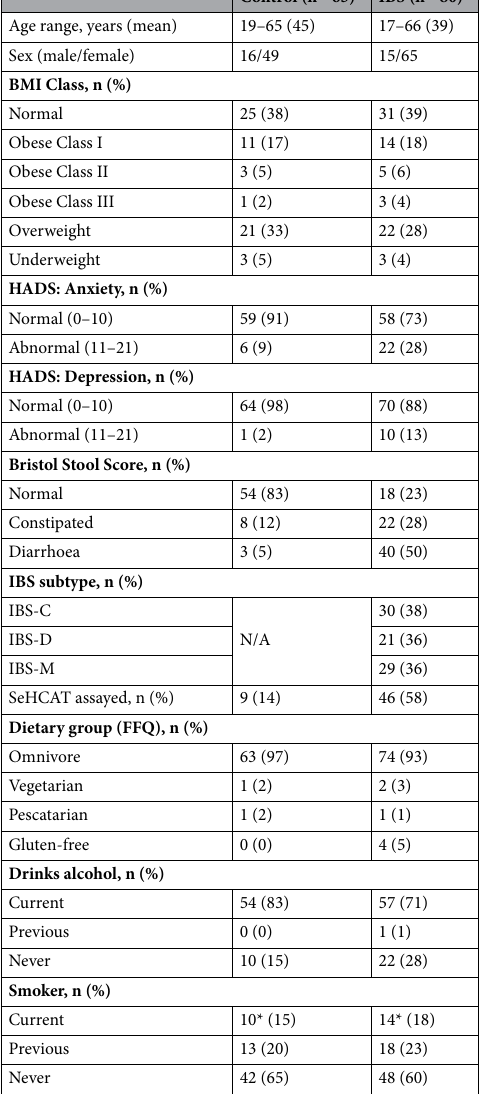
Table 1. Characteristics of control and IBS study population. * 1 subject in each group smoked e-cigarettes. BMI: Body Mass Index, FFQ: Food Frequency Questionnaire, HADS: Hospital Anxiety and Depression Scale, N/A: not